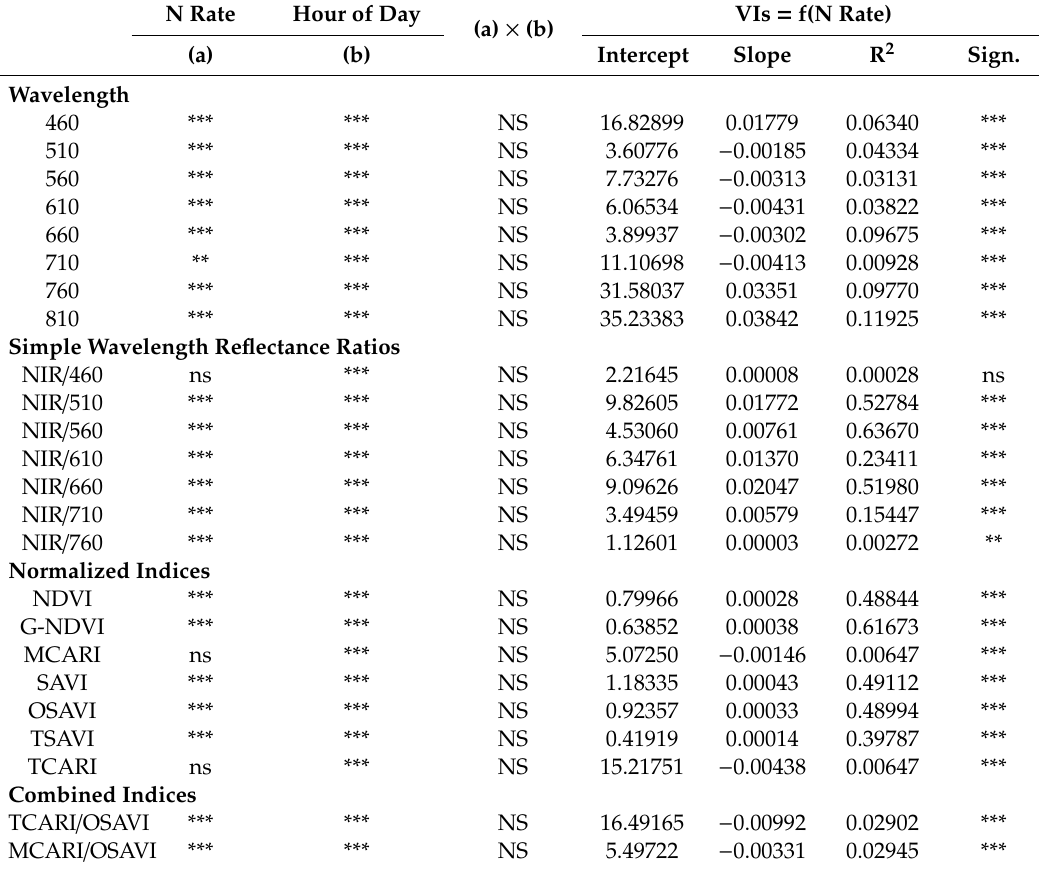
Table 4. Experiment 3#. Statistical significance of each of the factors (N rate, and hour of the day) and of the interaction between factors by ANOVA, and linear regression analysis between N fertilization rates and VIs responses. * p < 0.05, ** p < 0.01, *** p < 0.001, NS not